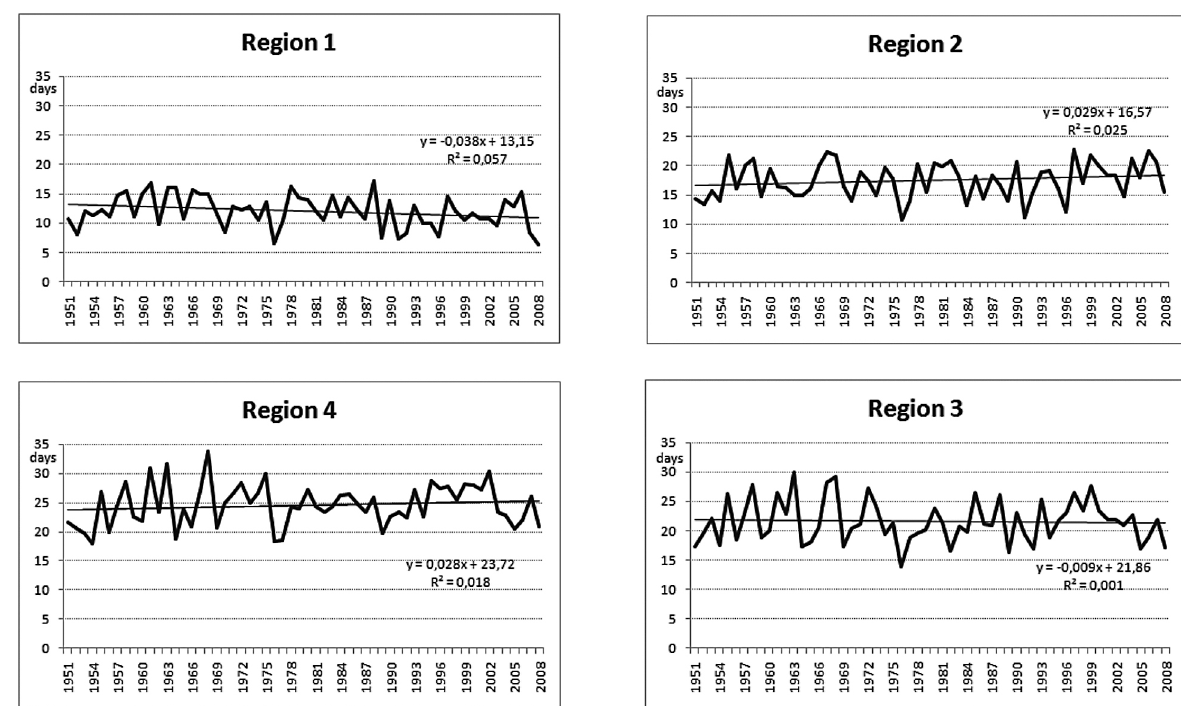
Fig. 5. The average multi-year courses of days with storms for distinguished regions. Data from the period 1951–2008.